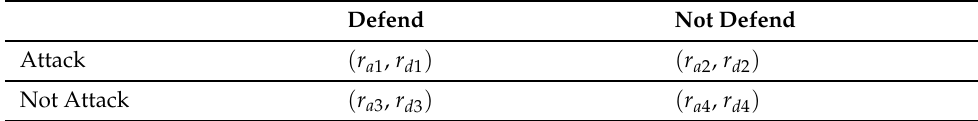
Table 1. Attacker/defender normal-form